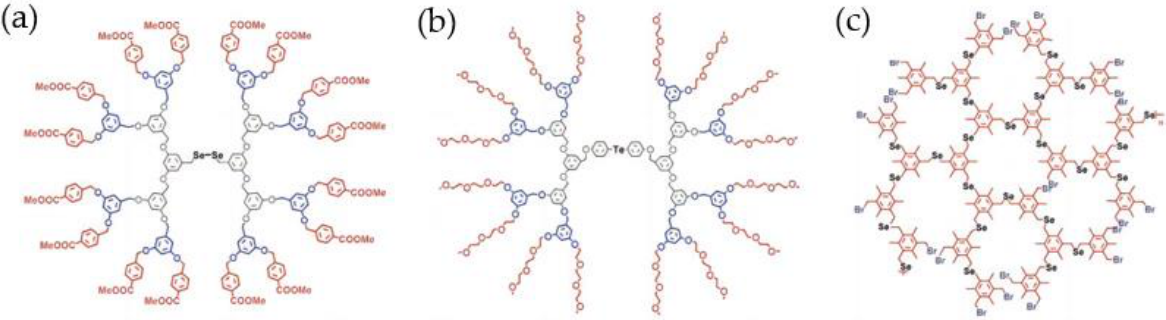
Figure 5. Selenoenzyme model based on dendrimers and hyperbranched polymers. ( a ) Dendrimers containing active sites of selenium. ( b ) The second-generation dendrimers with telluride moiety. ( c ) Hyperbranched compound model of selenium-containing catalyst. Reproduced with permission from X. Huang, et al. [10].